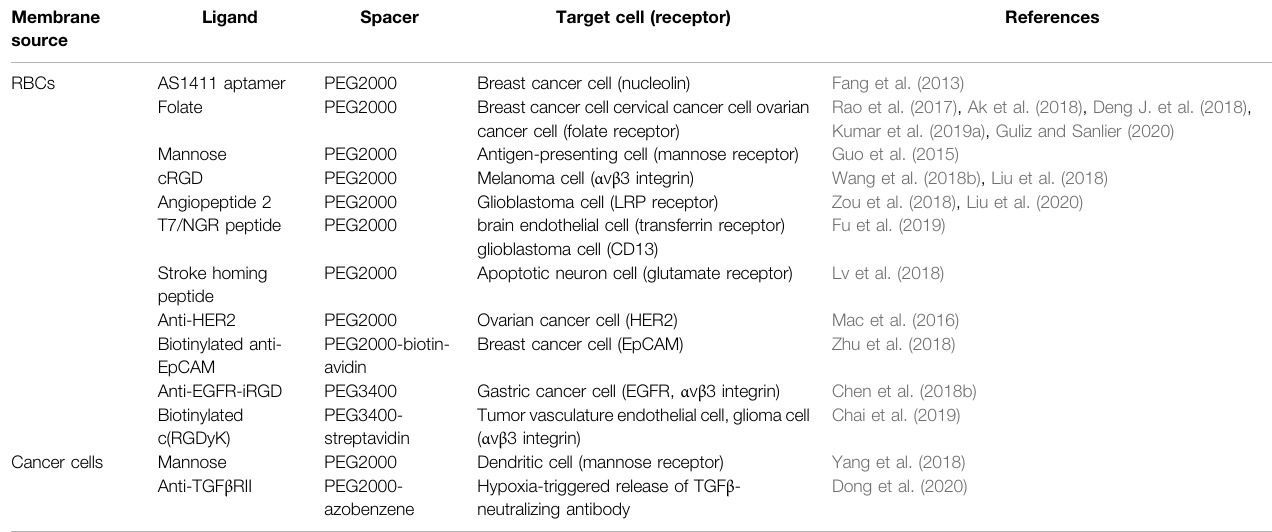
TABLE 3 | Summary of the introduction of different types of ligands into cell membrane coatings for functionalization by lipid insertion. Membrane